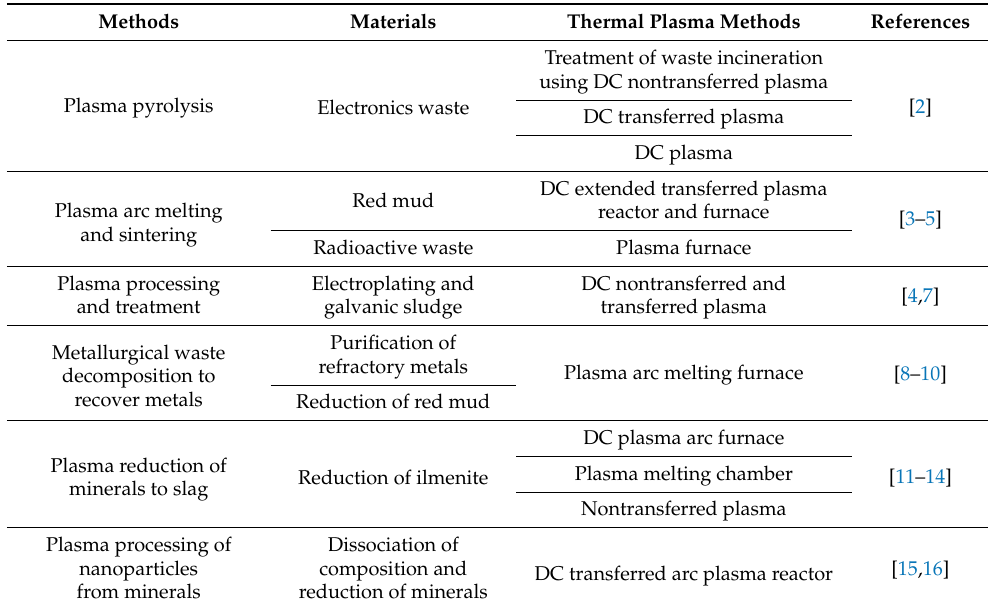
Table 1. Thermal plasma methods for various metal recovery.